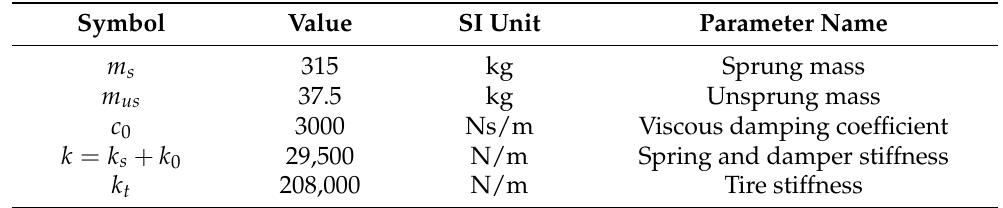
Table 2. Vertical dynamics